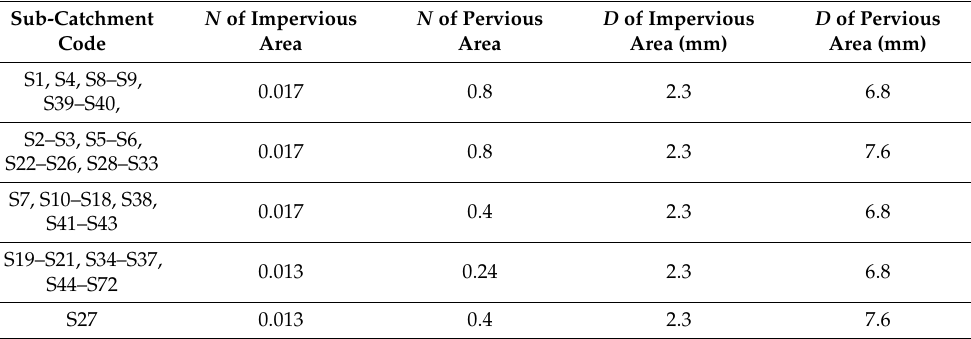
Table 5. Comparison between MRD S and MRD I of typical rainfall processes.